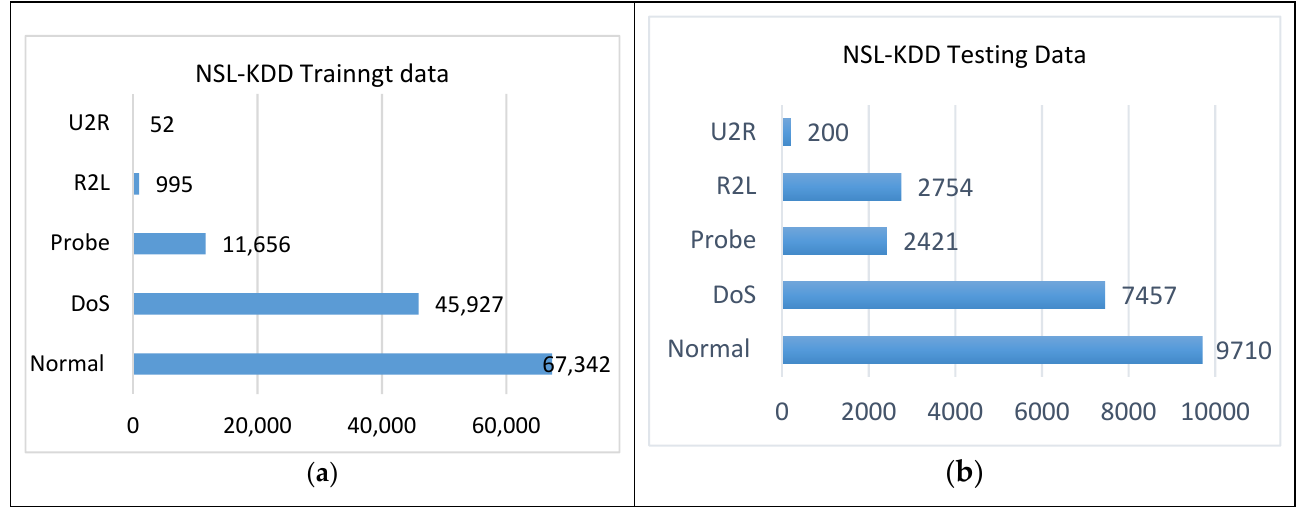
Figure 6. NSL-KDD ( a ) training data and ( b ) testing data.